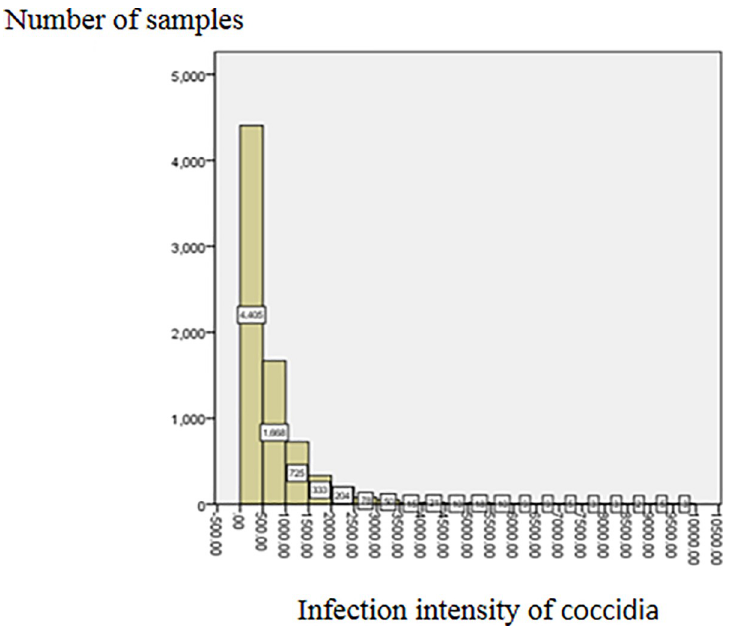
Fig 3. Distribution of sheep coccidia infection intensity.